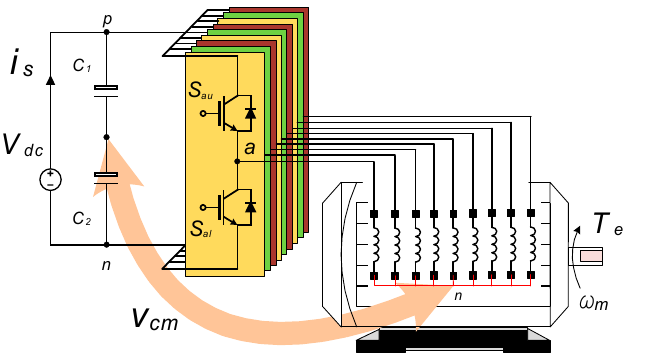
Figure 1. Schematic diagram of nine-phase inverter feeding a symmetrical nine-phase motor. Although nine-phase machines are distinguished by their lower dv / dt value; they still have the same peak common mode voltage (CMV) as the three-phase machine, which equals V dc [11,12]. Regardless of the number of phases, the CMV seems a common problem in drive systems. Hence, it represents one of the leading research topics to be investigated in the drive systems, where it leads to multiple unwanted effects such as